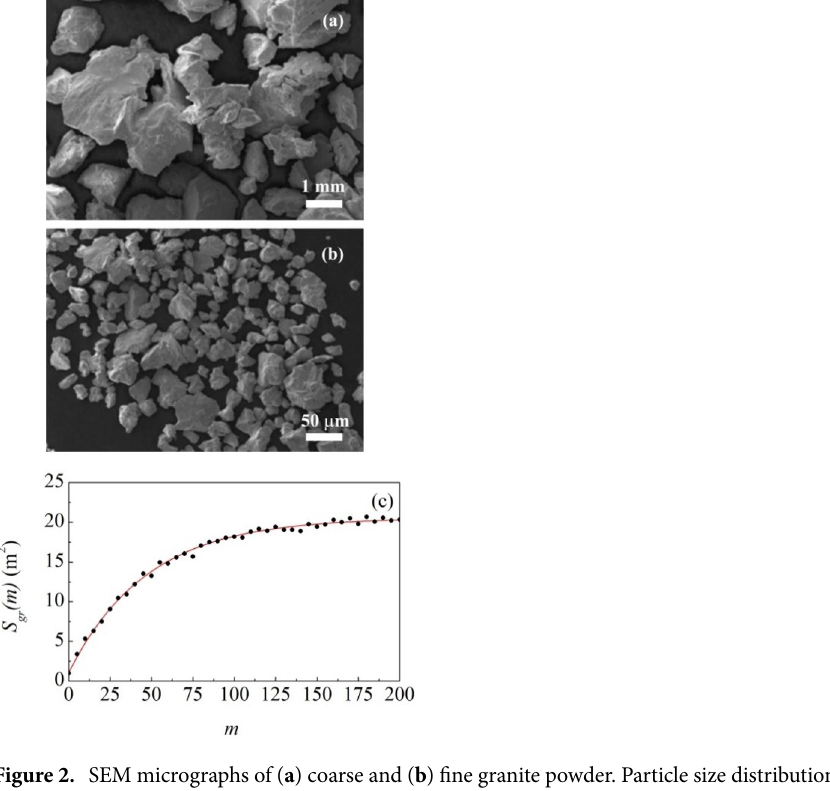
Figure 2. SEM micrographs of ( a ) coarse and ( b ) fine granite powder. Particle size distributions are shown. ( c ) The total surface area of granite powder, S gr ( m ) , as a function of the number of impacts, m . The best-fitted curve is